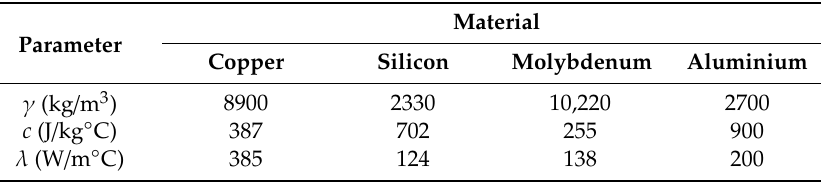
Figure 5. Thermal model of the thyristor (1—cathode copper pole; 2—silicon chip; 3—molybdenum disc; 4—anode copper). Table 1. Material data.